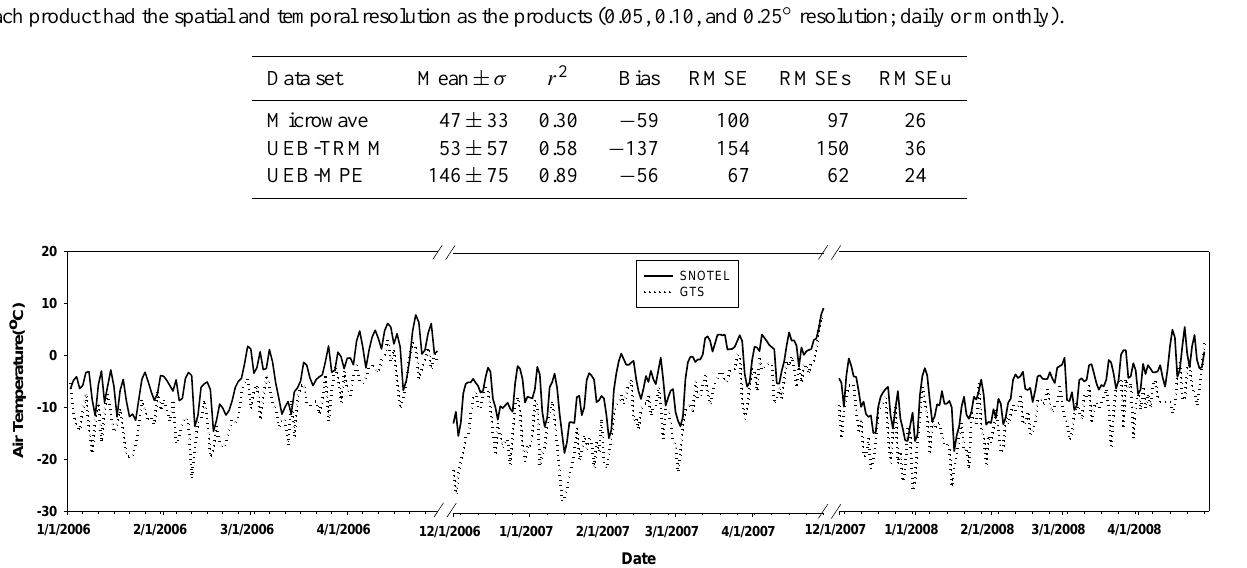
Table 5. Statistical summary of the evaluation of SWE products compared to the SNODAS product. The SNODAS product compared to each product had the spatial and temporal resolution as the products (0.05, 0.10, and 0.25 ◦ resolution; daily or monthly).